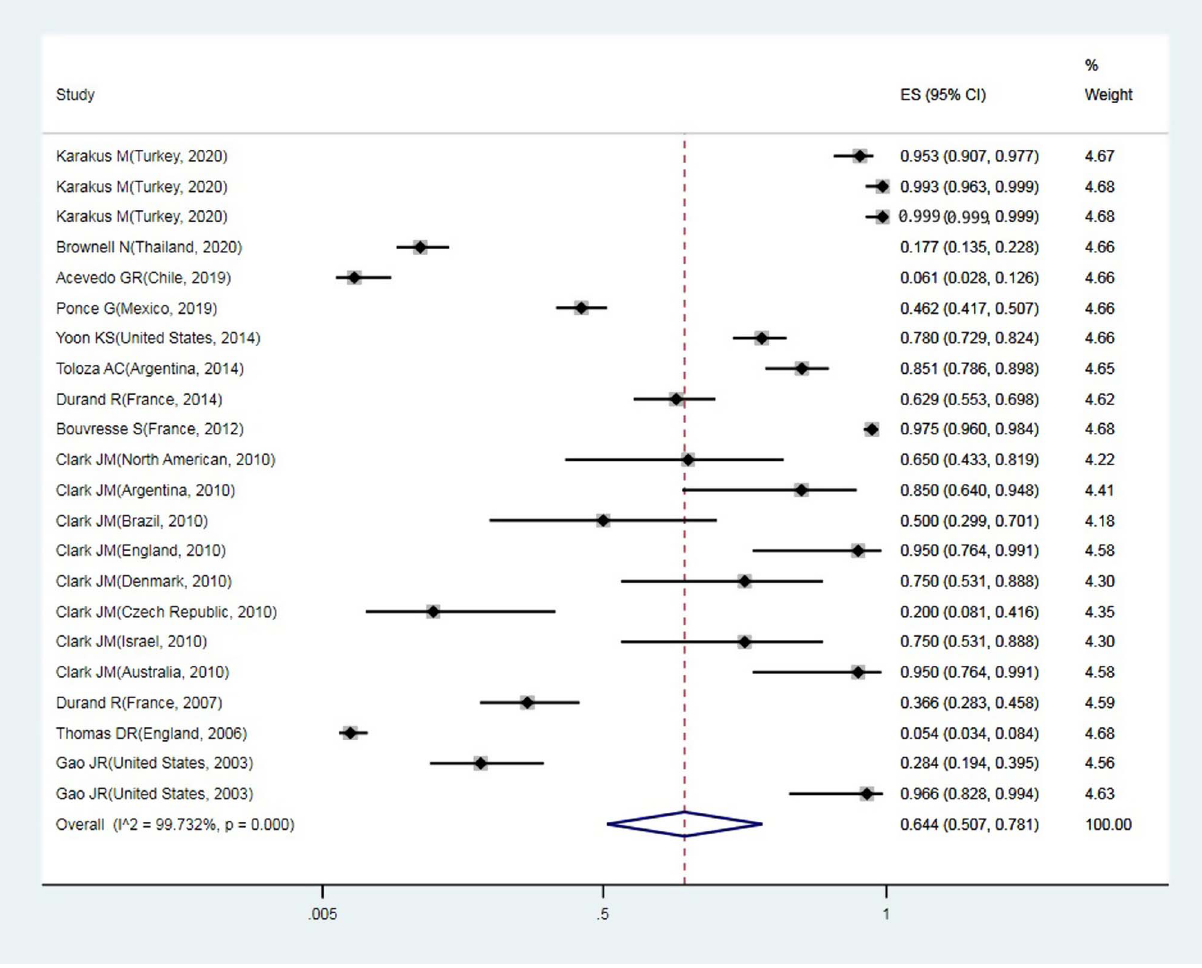
Figure 3. Forest plots of the proportion of homozygote resistant and 95% con fi dence interval based on a random effect model in meta-